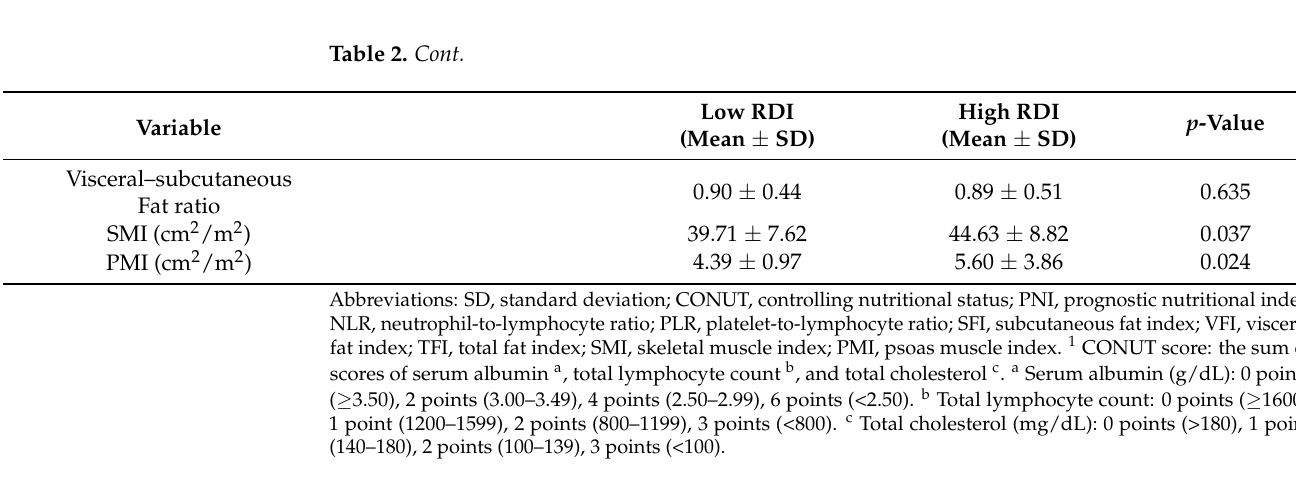
Table 3. Univariate and multivariate analysis according to relative dose intensity